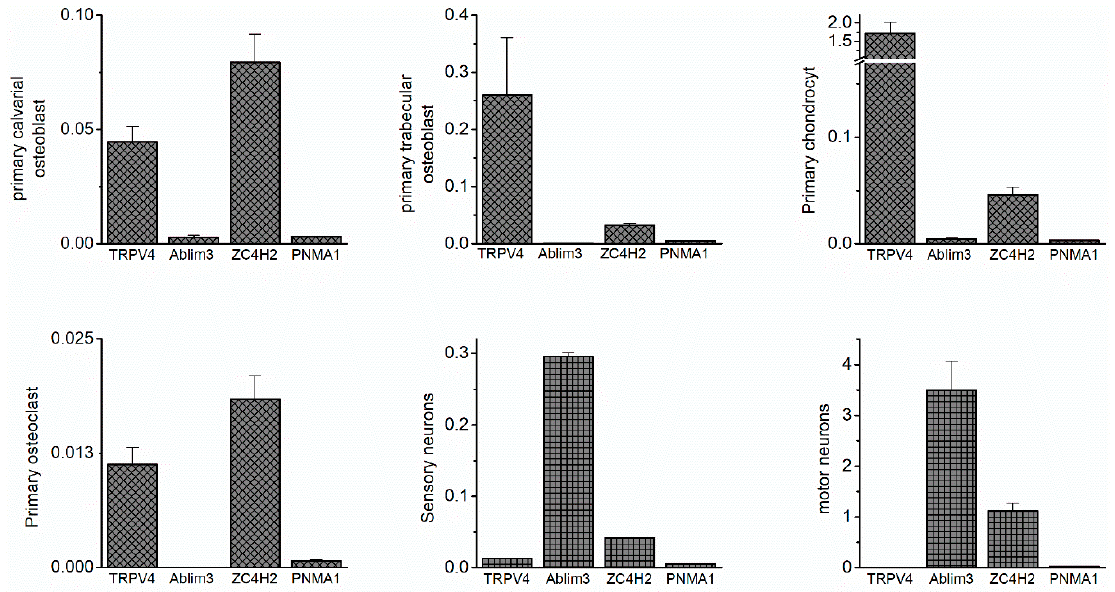
Figure A1. Initial evaluation of other MAPPIT hits. mRNA expression of TRPV4 and the indicated MAPPIT hits in the indicated mouse tissues. Values were normalized to the internal control HPRT.